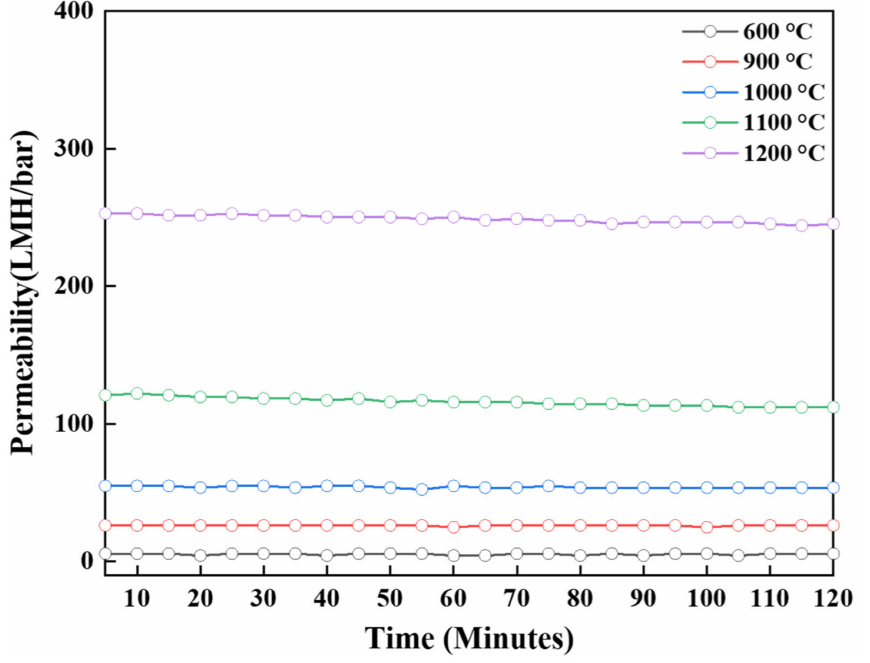
Figure 11. Effect of different sintering temperatures on the pure-water permeability of Al 2 O 3 ultrafil- tration (UF) membranes.